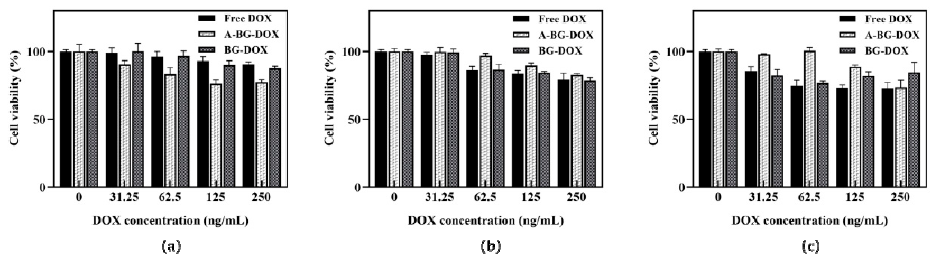
Figure 5. Cytotoxicity of free DOX, BG-DOX, and A-BG-DOX against HepG2 tumor cells in media at ( a ) pH 6.5, ( b ) pH 7.4, and ( c ) L02 cells in normal culture conditions. ( a ) pH 6.5, ( b ) pH 7.4, and ( c ) L02 cells in normal culture conditions.